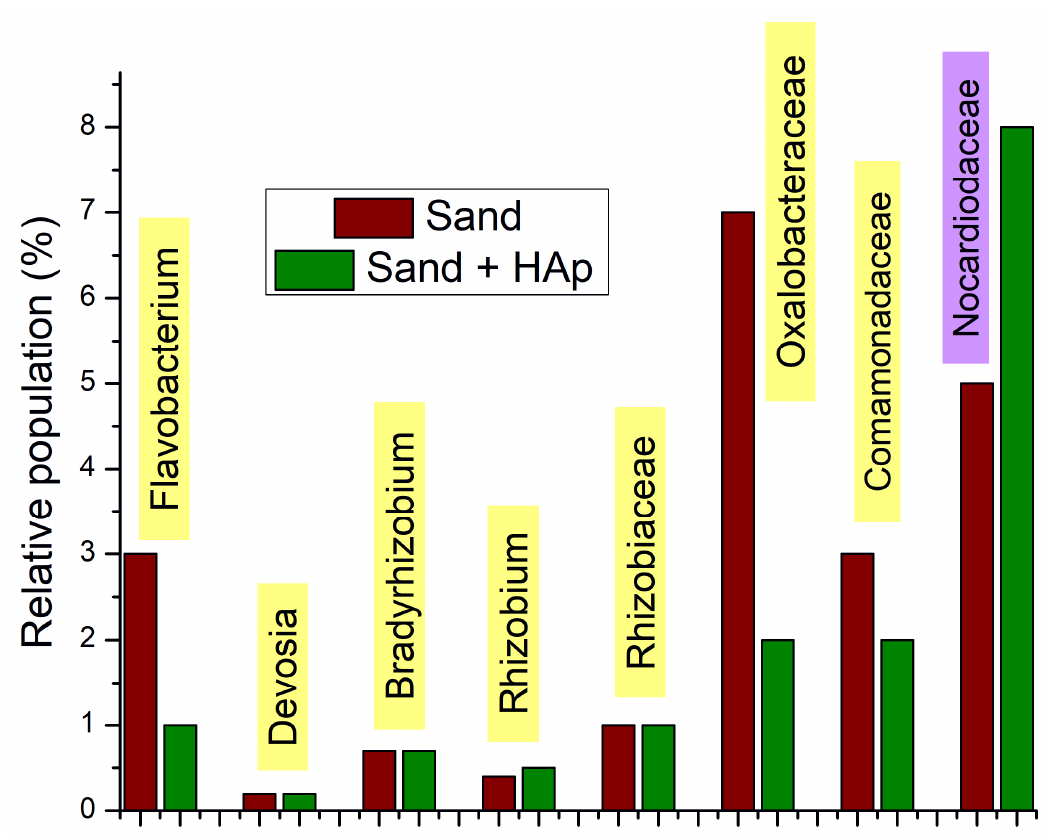
Figure 11. Relative presence of selected taxa positively correlating with the agricultural fertility of the soil before and after its treatment with HAp nanoparticles. Gram-negative taxa are framed in yellow, while the single Gram-positive taxon is framed in violet.